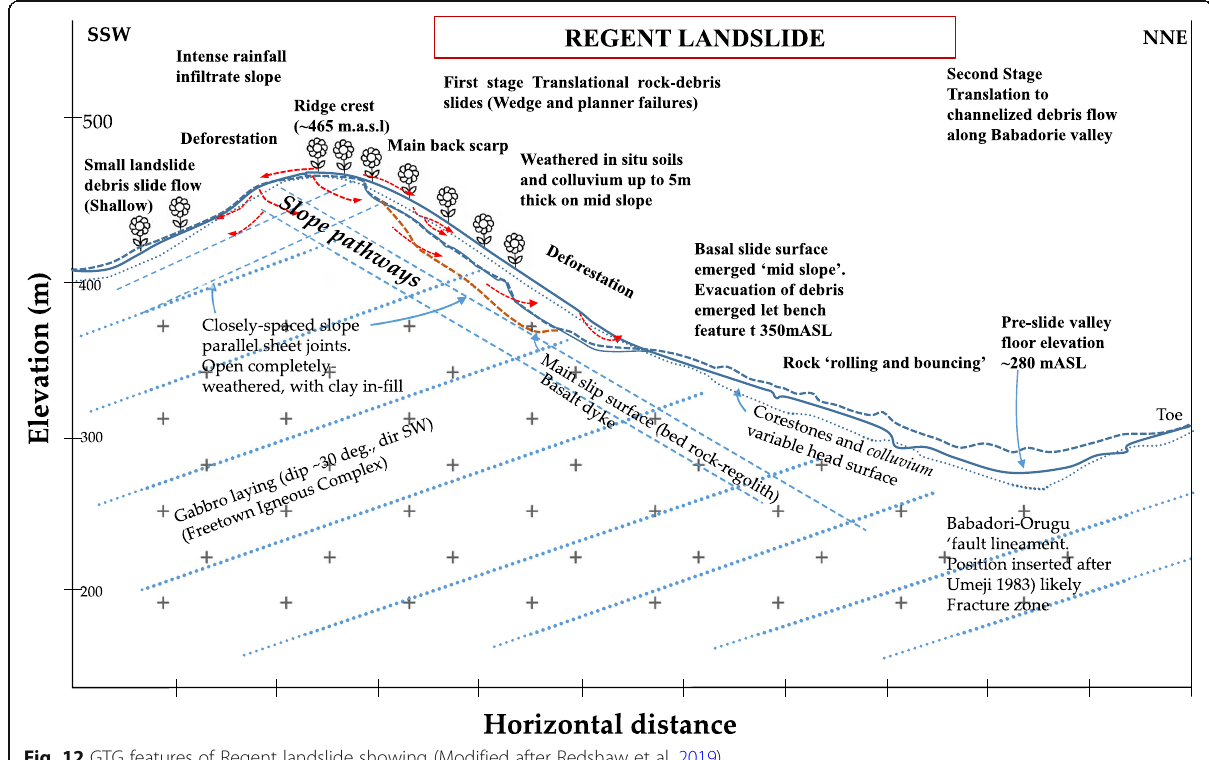
Fig. 12 GTG features of Regent landslide showing (Modified after Redshaw et al. 2019)